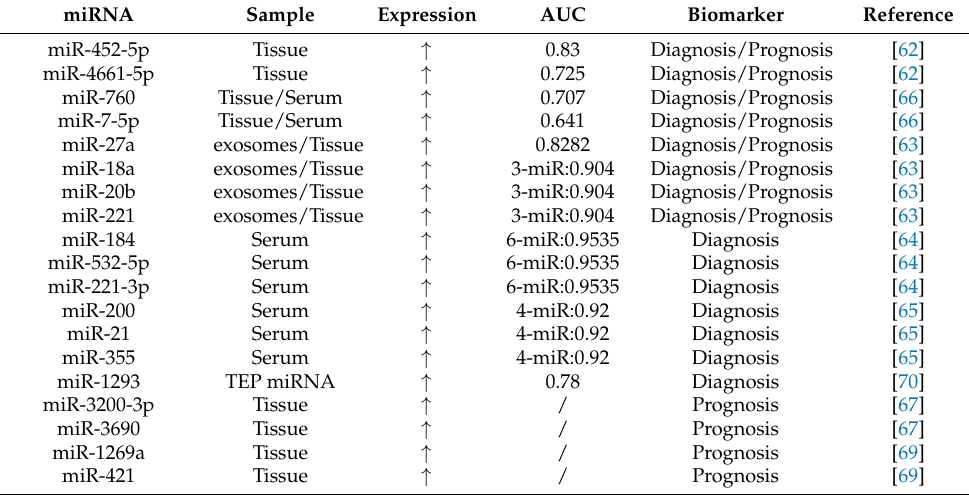
Table 2. MicroRNAs as biomarkers for diagnosis and prognosis of HCC.